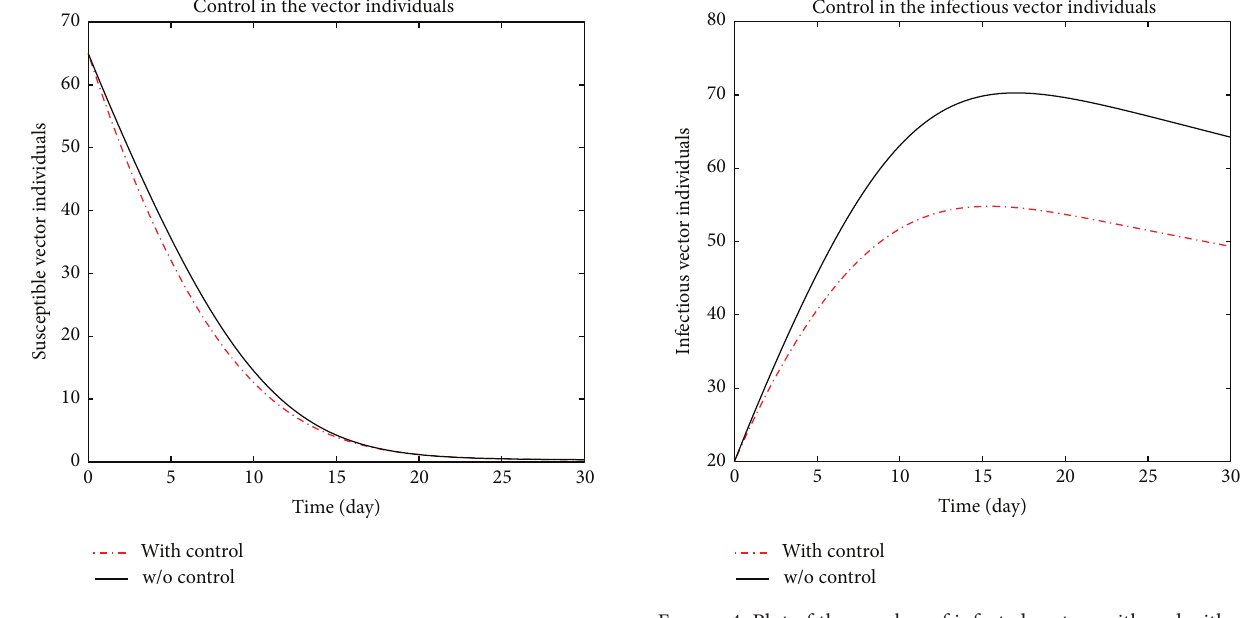
Figure 3: Plot of the number of susceptible vectors with and without control, 𝑢 1 ̸=0 , 𝑢 2 ̸= 0 .